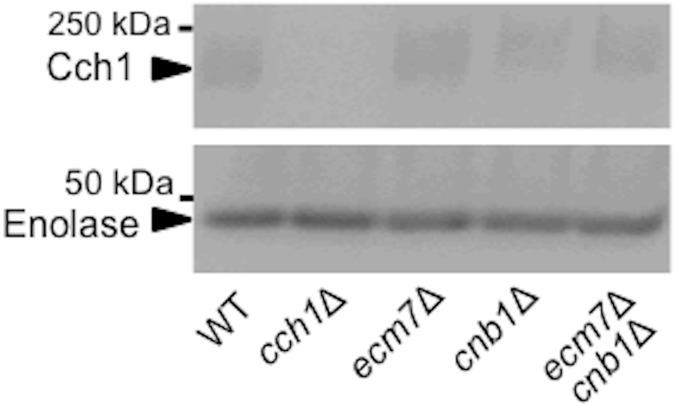
The deletion of ECM7 and CNB1 does not affect the amount of Cch1.Cells with various deletion mutations were exposed for 2 h to 6 μM α-factor and crude extracts were prepared. The amount of Cch1 in these cells was assessed by Western blotting. Enolase is an internal marker.